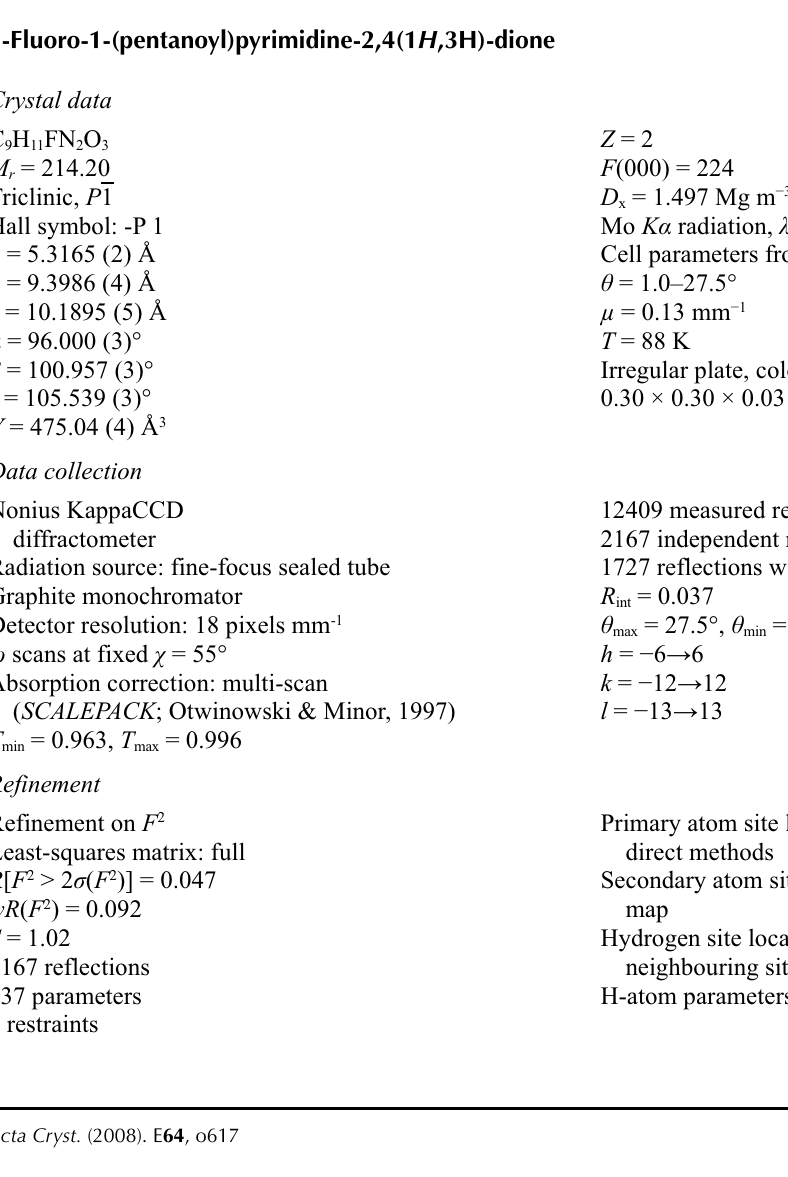
View of the title compound showing the atom-labelling scheme. Displacement ellipsoids are drawn at the 50% probability